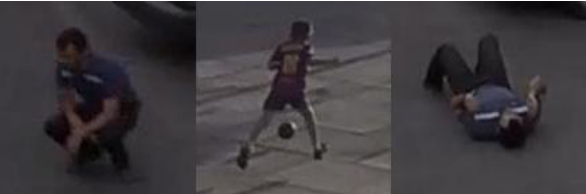
Figure 9. Human in different situations